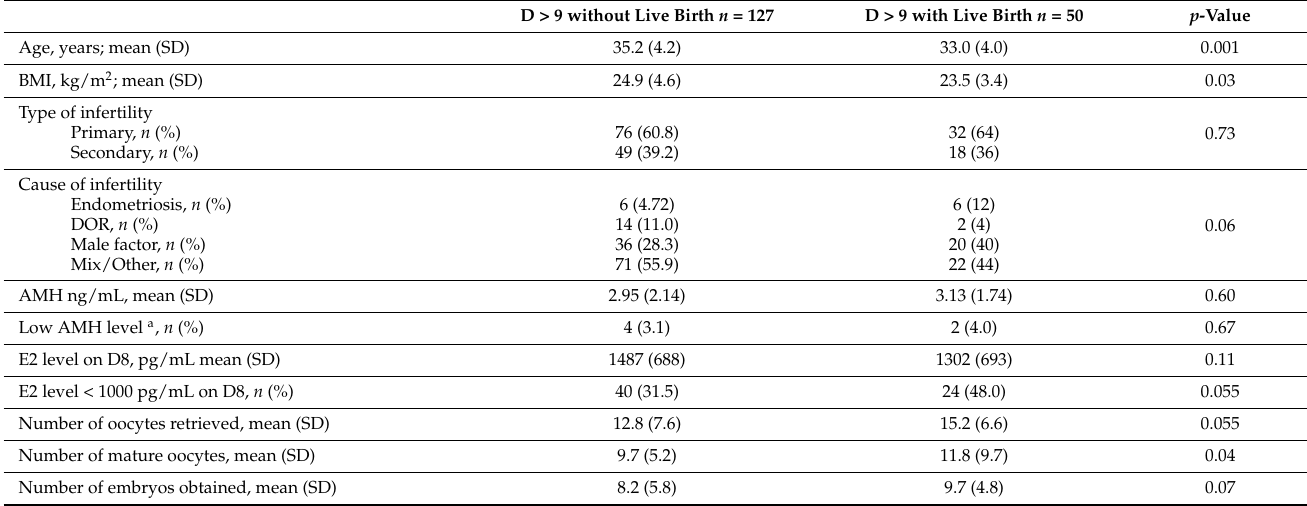
Table 4. Predictive factors of live births when ovulation trigger occurs at D > 9. D > 9 without Live Birth n = 127 D > 9 with Live Birth n = 50